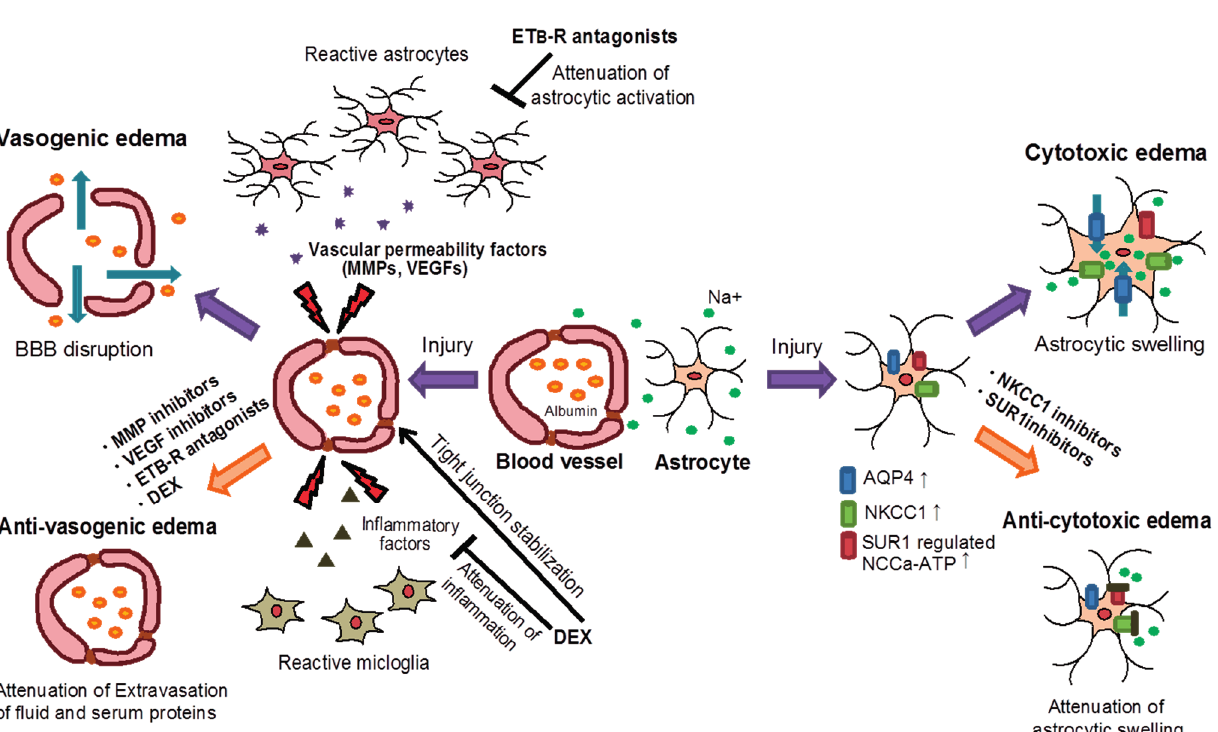
AQP4, KNCC1 and SUR1-regulated NC Ca-ATP would be beneficial for cytotoxic edema. Blue arrows: flow of water, green arrows: flow of Na + , orange spheres: albumin, green spheres: Na + , purple spheres: vascular permeability factors, brown triangle: inflammatory